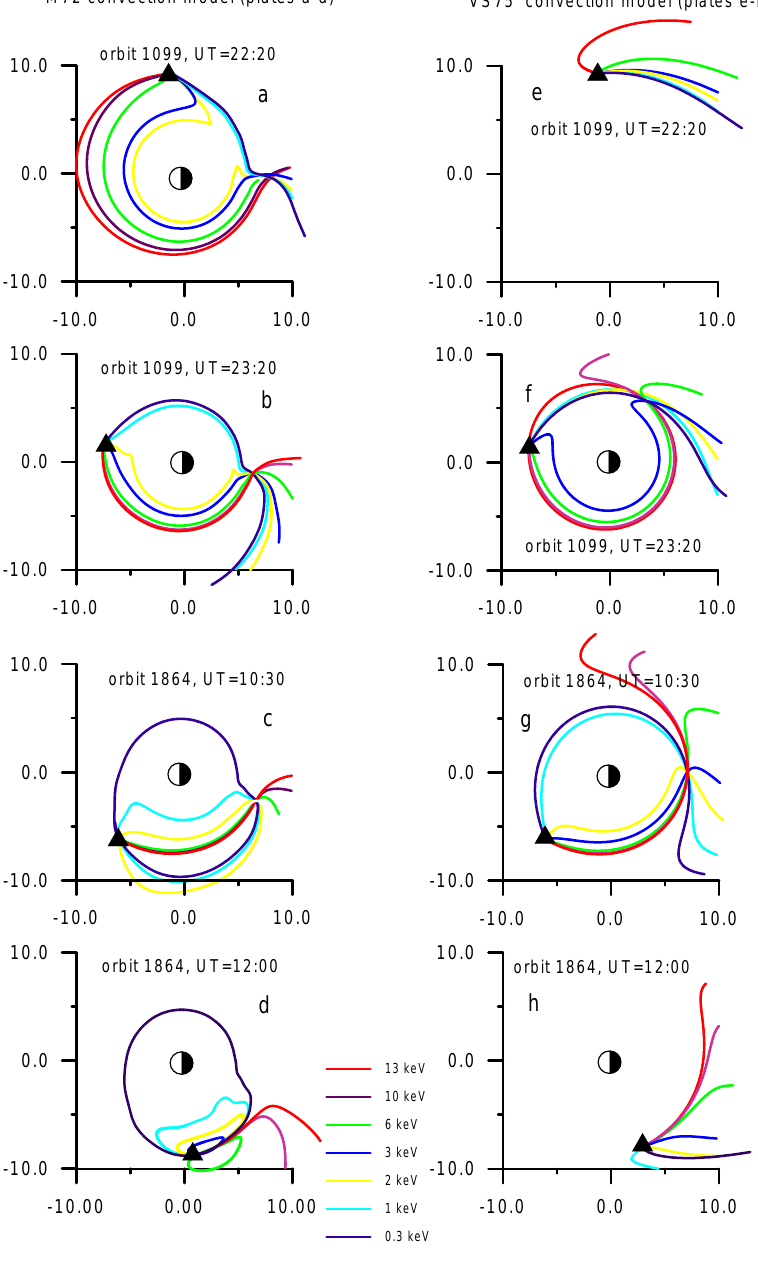
Fig. 6. Examples of the ion trajecto- ries traced back in time from the par- ticular points at the equatorial plane- projections of the Interball-2 orbital points. Black triangles are the points in the equatorial plane. Calculations were made for two points of orbit 1864 (10:30, 12:00UT) and for two points of orbit 1099 (22:30,